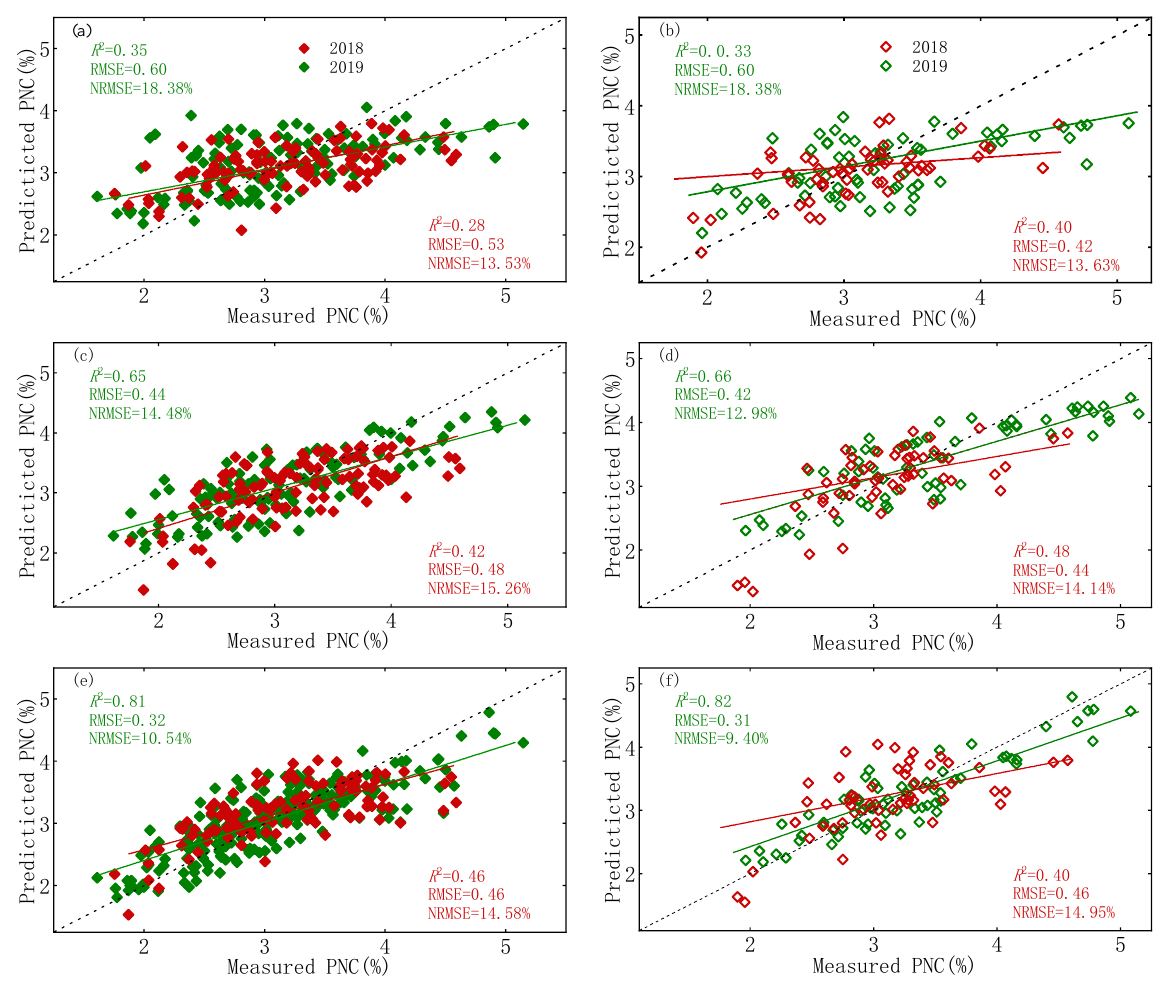
Figure 6. Predicted versus measured PNC. Predicted PNC was estimated by models constructed from the three optimal spectral indices to estimate the effect of potato PNC in different planting years (2018 and 2019). ( a , c , e ) modeling dataset; ( b , d , f ) validation dataset. Figure 8 shows the accuracy of the three optimal spectral indices for estimating PNC in different potato growth periods. Figure 8a,b show that the PNC estimation model constructed from FDR 542 for the multiple potato growth periods produces accurate PNC estimates only in S3 but inaccurate PNC estimates in the other three growth periods. Figure 8c,d indicate that, compared with FDR 542 , the PNC estimation model constructed from DSI (578,494) produces more accurate PNC estimates for all four growth periods. The most accurate PNC estimate is for growth period S3, which has modeling and validation R 2 values of 0.62 and 0.52, RMSE values of 0.40 and 0.36, and NRMSE values of 13.56% and 12.74%, respectively. Figure 8e,f show that the PNC estimation model built from TBI5 (530,734,514) produces the most accurate PNC estimates of the three spectral indices for all potato growth periods. The best estimates are for growth period S3, which has modeling and validation R 2 values of 0.71 and 0.54, RMSE values of 0.35 and 0.45, and NRMSE values of 12.12% and 15.54%, respectively. The poorest estimates are for growth period S1, which has modeling and validation R 2 values of 0.52 and 0.61, RMSE values of 0.51 and 0.45, and NRMSE values of 13.88% and 11.75%, respectively. The combined modeling and validation results show that the PNC estimation models constructed from the three optimal spectral indices all work best in S3 and poorly in